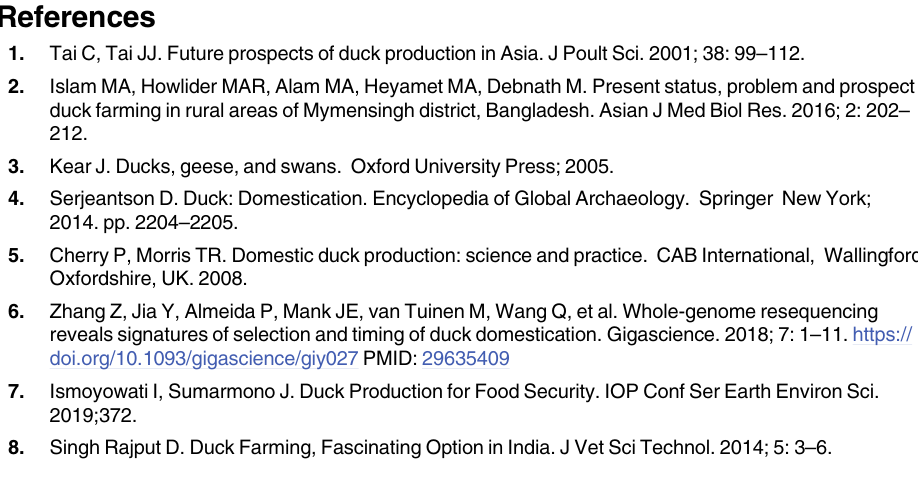
S1 Table. Details of sampling location of Andaman local duck. S2 Table. Details of the sequences used in the present study. S1 Fig. The number of sequences in each haplotype and the frequencies of the detected haplotypes of Andaman local